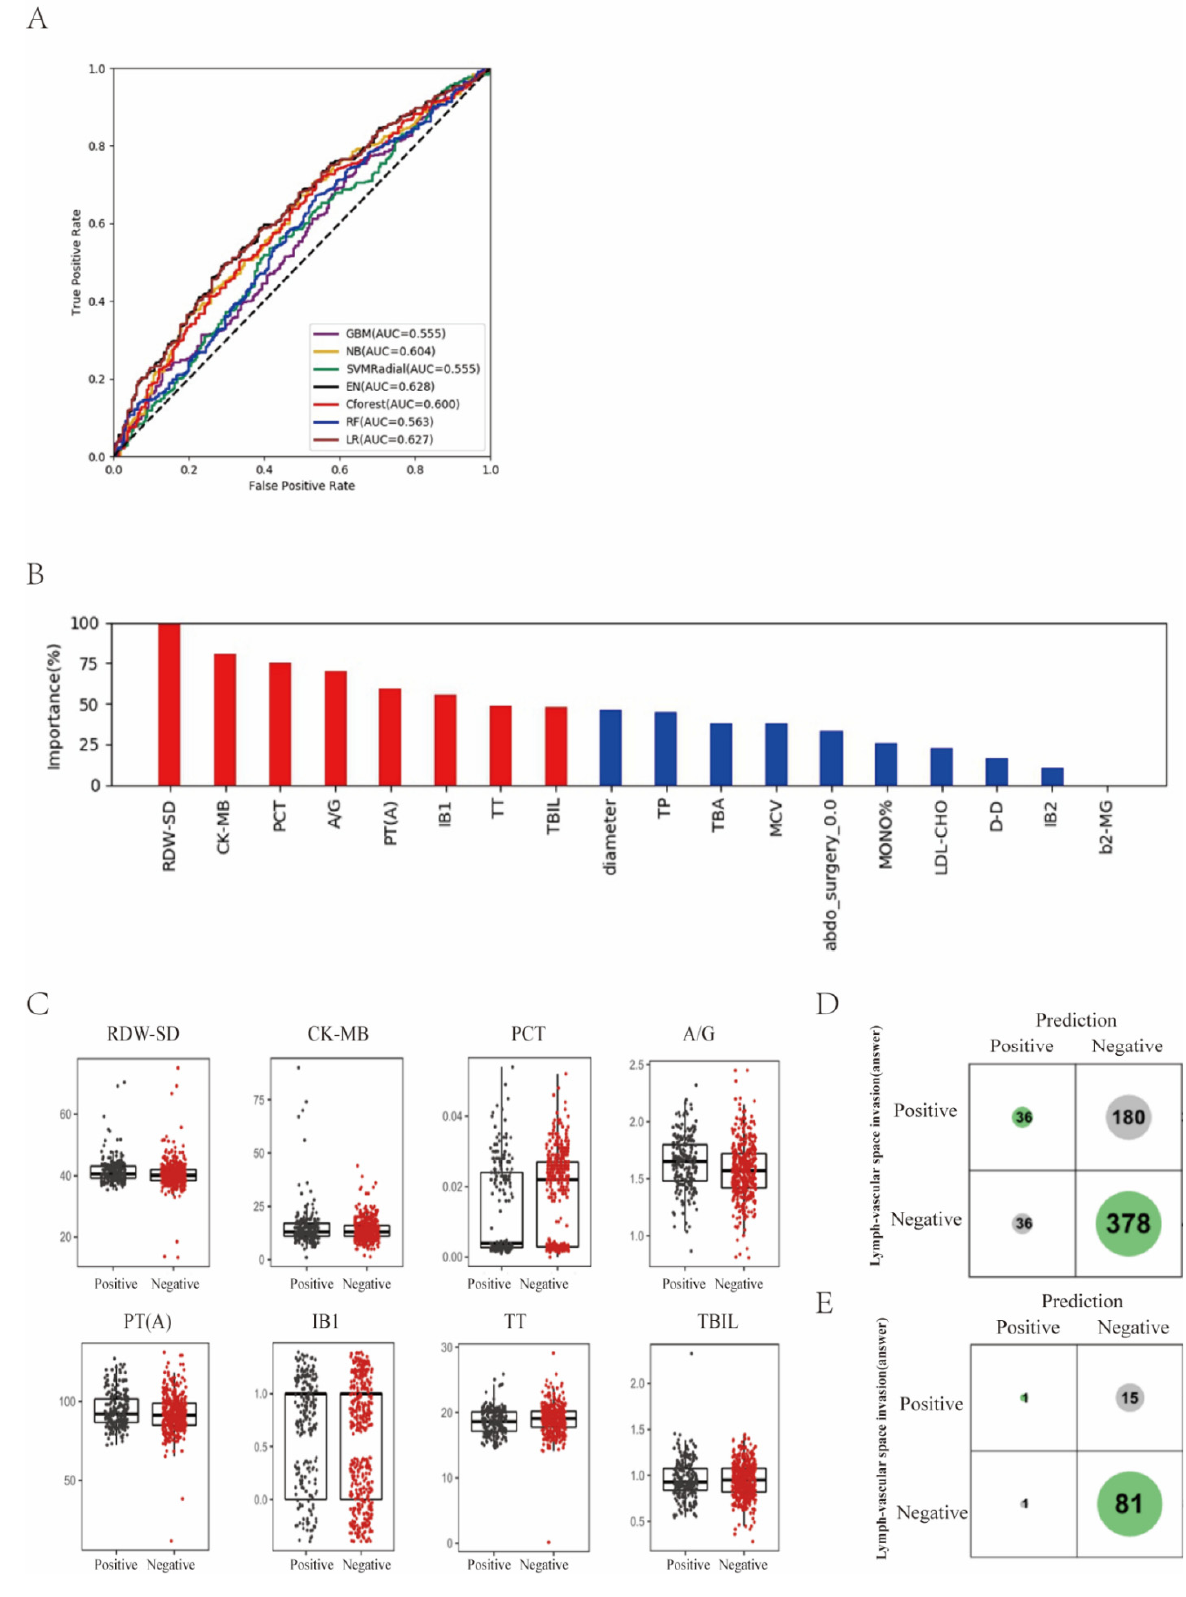
Figure 3. Prediction of lymph-vascular space invasion of cervical cancer based on preoperative blood markers using machine learning methods. ( A ) ROC curves derived from logistic regression for predicting lymph-vascular space invasion of cervical cancer based on all 75 peripheral blood markers using machine learning methods compared with logistic regression. ( B ) Relative im- portance of variables for prediction of lymph-vascular space invasion calculated in the EN. Variable